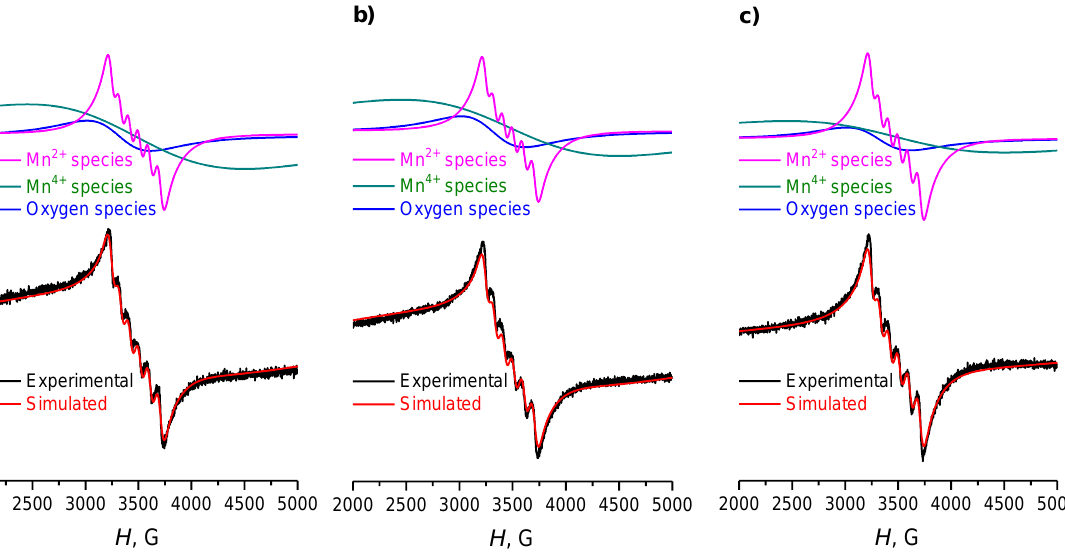
Figure 8. Experimental and simulated EPR spectra of Mn-Ce-Zr catalysts, calcined at ( a ) 500 °C, ( b ) 600 °C and ( c ) 700 °C. Different components of the spectra are presented above each simulated curve. Table 3. The components of simulated EPR spectra and their contribution to overall spectrum. The Contribution of the Species to Overall EPR Spectrum, % Catalyst